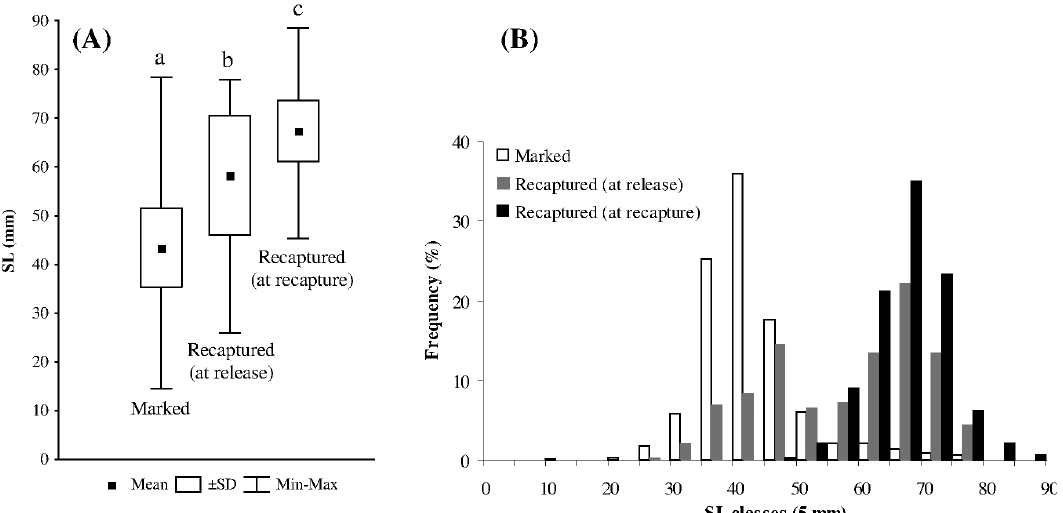
Fig . 4. − Comparison of (A) specimen size (mean±SD and range) and (B) size-frequency distribution of marked-recaptured Bolinus brandaris . Different superscript letters denote statistically significant differences in mean SL between groups (K-W: Dunn test, p